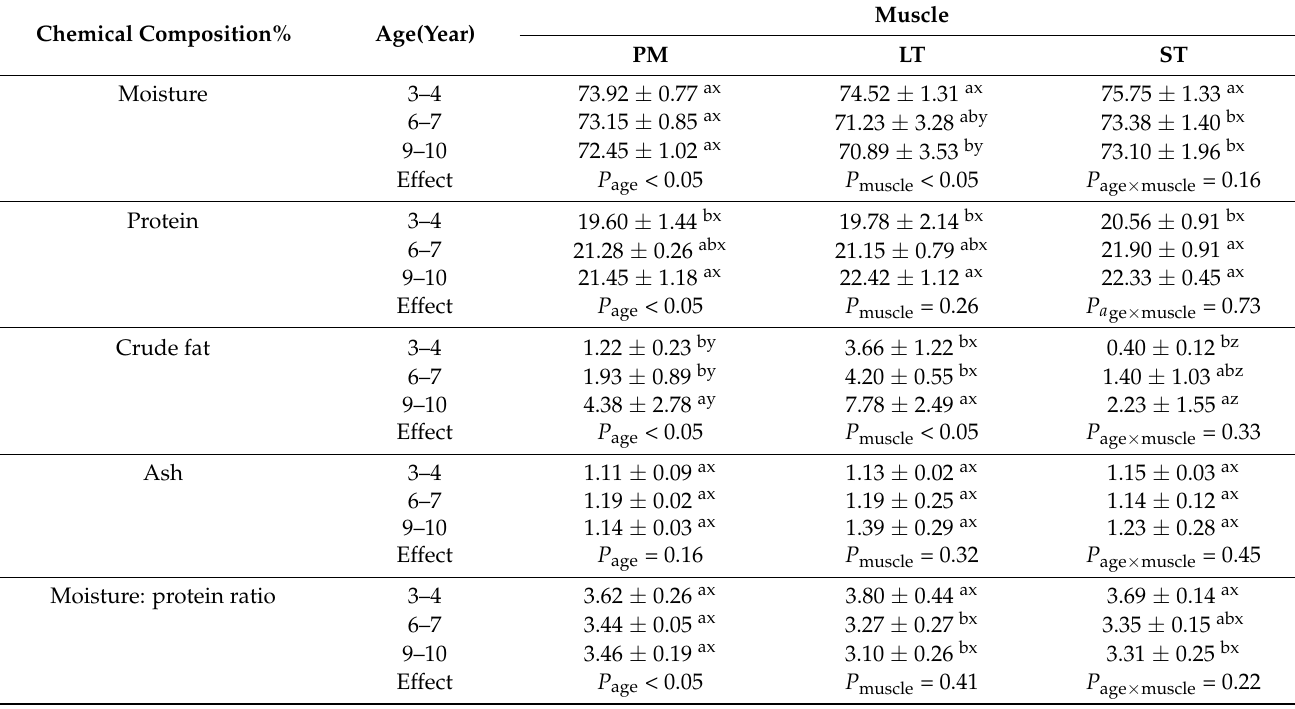
Table 1. Mean moisture, protein, fat, and ash components for the Longissimus thoracic (LT), Semitendi- nosus (ST), and Psoas major (PM) muscle samples from Alxa Bactrian camels ( n = 5, mean ± standard error) slaughtered at three different